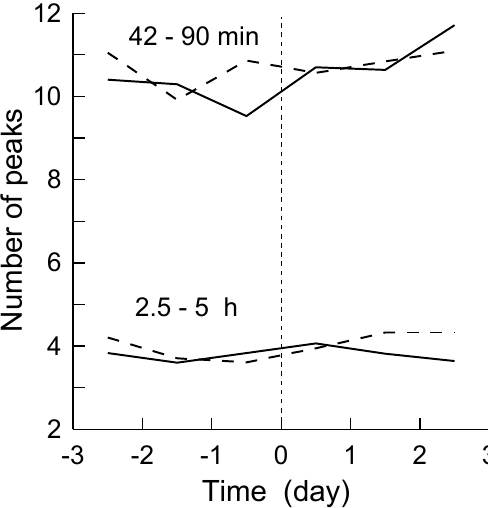
Fig. 9. Change in diurnal mean numbers of prominent spectral peaks around the occurrence time of large earthquake. The solid lines are for the numbers derived from the power spectra of ground- pressure variations. The dashed lines are the same, but for the seis- mometer records. The zero time corresponds to earthquake occur- rence